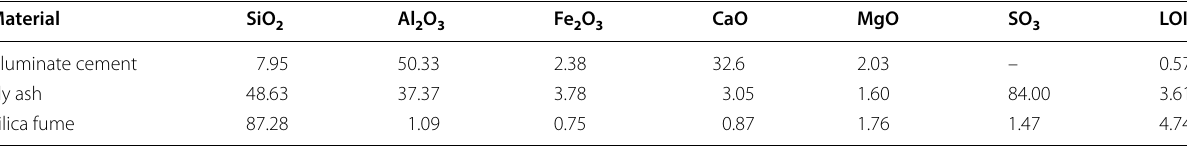
Table 1 Chemical compositions of the